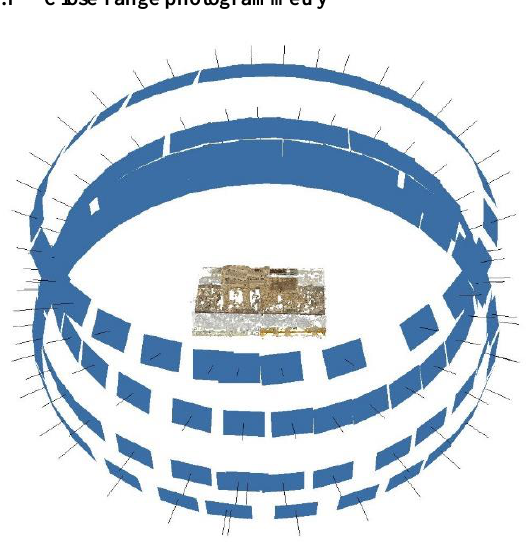
Figure 6. Image alignment and sparse cloud of tie